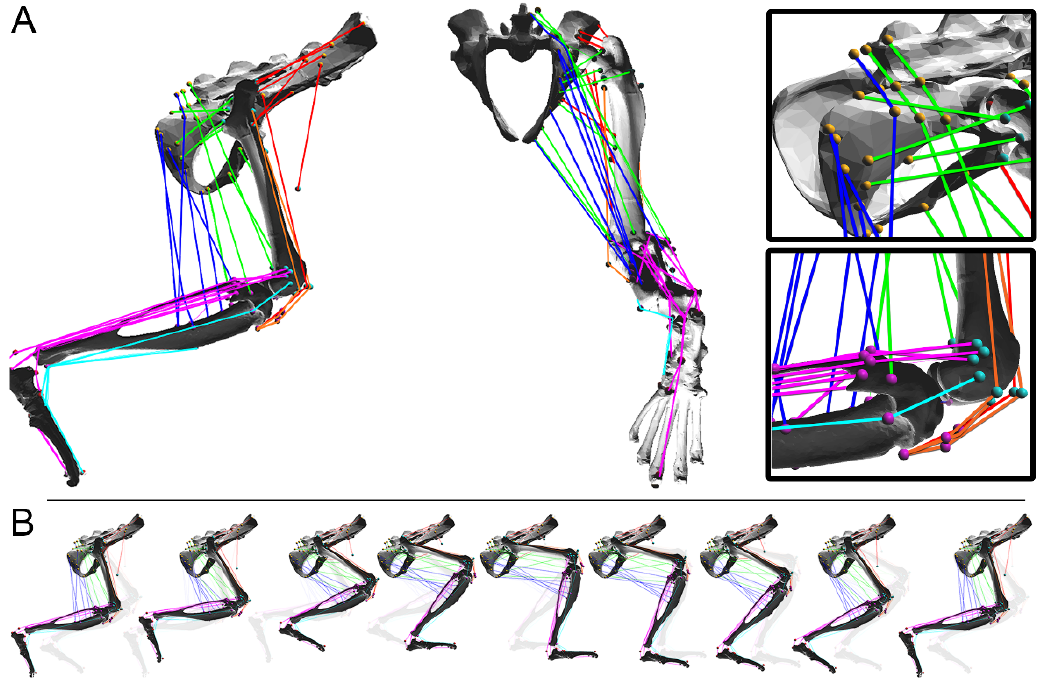
Figure 1. ( A ) A rat hindlimb model with thirty-eight muscles. Joints are modeled as hinges fixed relative to the proximal bone and permitting motion in the sagittal plane. Color is included to visually distinguish muscle groups but has no explicit functional significance. ( B ) The model is moved through a sagittal plane walking pattern that replicates rat locomotion on flat ground. Constituent joint torques, such as passive viscoelastic torques from stretching muscles, are calculated during this walking cycle.